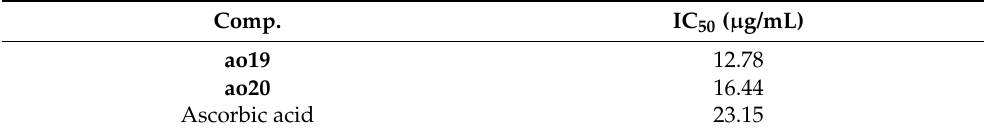
Table 63. In vitro antioxidant activity of the synthesized compounds ( ao19 – ao20 ). Comp.